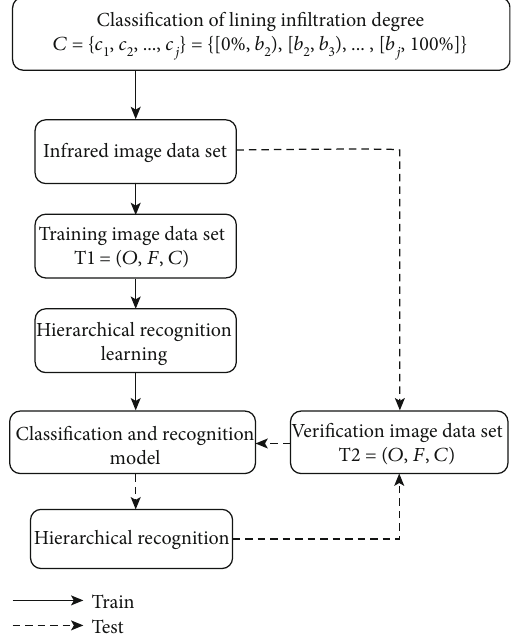
Figure 1: Classi fi cation recognition method for tunnel lining in fi ltration based on a deep learning